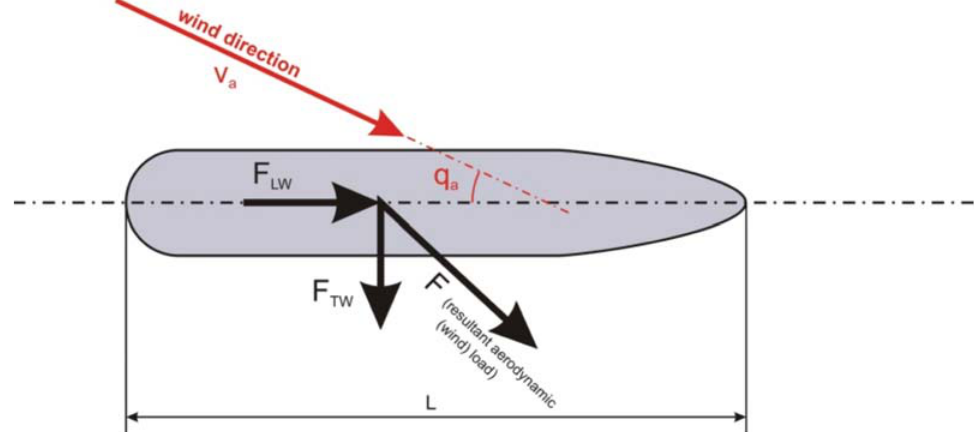
Fig. 8. Aerodynamic loads on